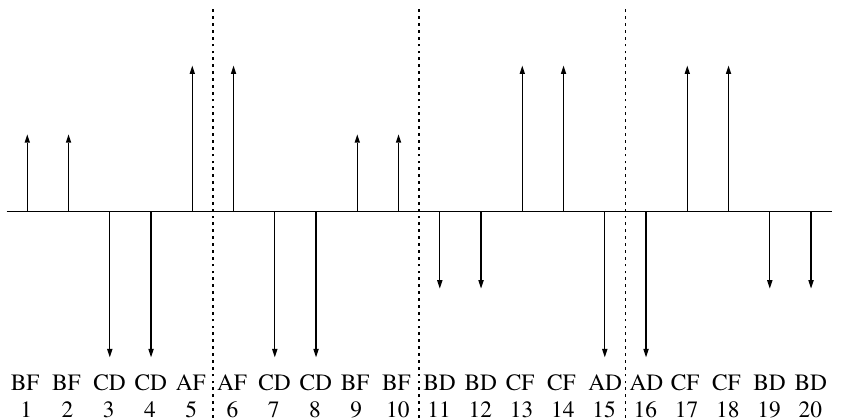
FIG. 3. AGS superperiod. Here up and down vectors show the direction and magnitude of the focusing gradient, and the letters denote the names assigned to each series of